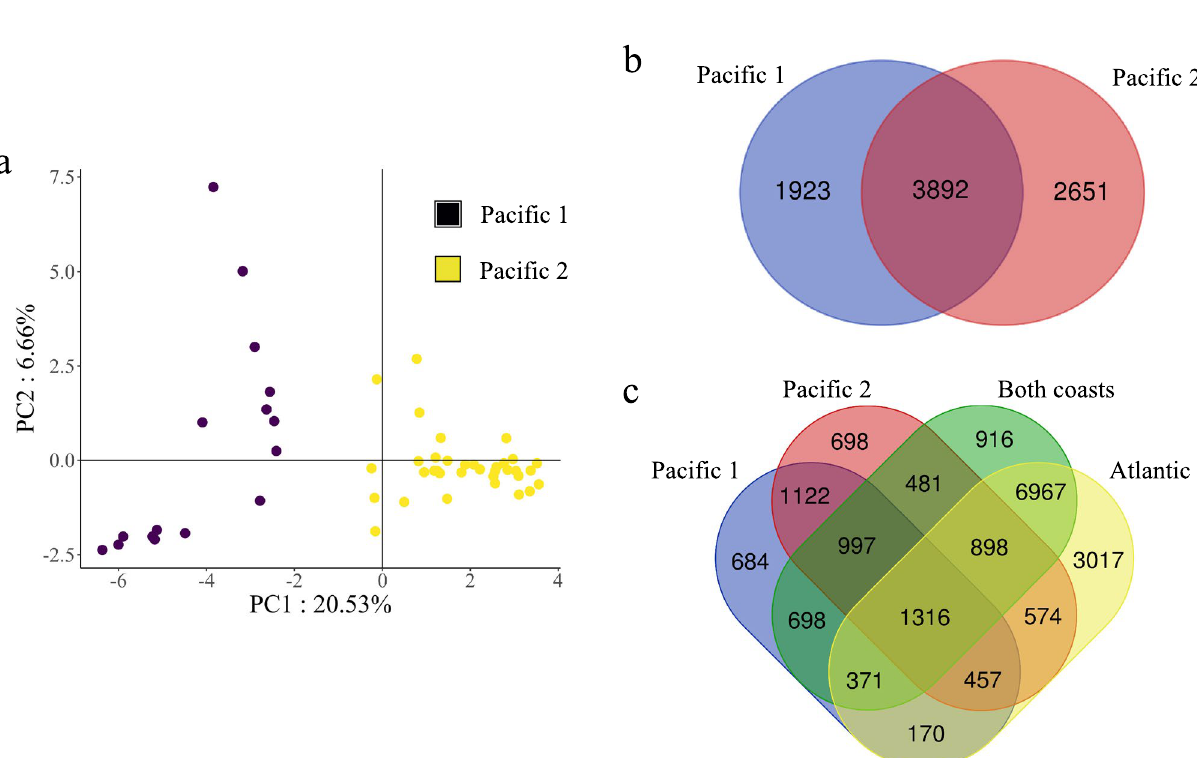
Figure 4. Principal component analyses and Venn diagrams. ( a ) Principal component analysis of 51 accessions of coconuts originated in the Pacific coast. ( b ) Venn diagram for the different sets of SNPs related to the genetic structure found in the Pacific coast group. ( c ) Venn diagram for the different sets of SNPs related to the structure found in all accessions.